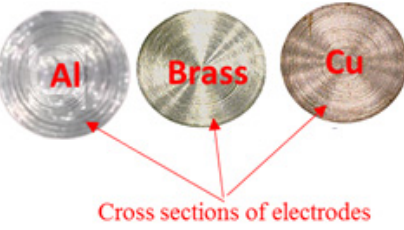
Figure 2. Cross section view of aluminium, brass and copper electrodes.